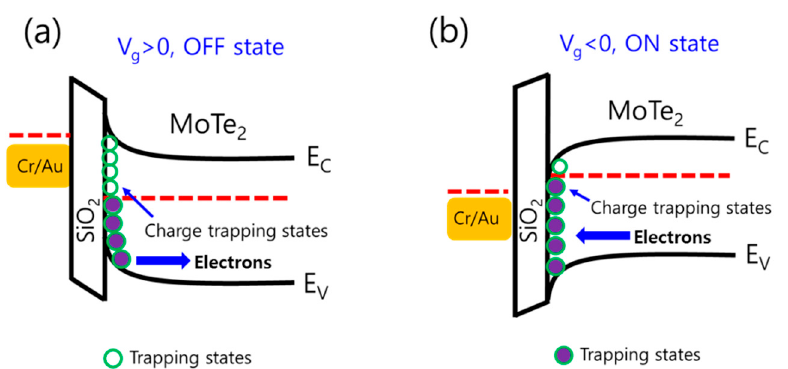
Figure 3. Schematic band diagram of MoTe 2 FET with trapped states at the MoTe 2 / SiO 2 interface. ( a ) When negative gate is applied. ( b ) When positive gate is applied.